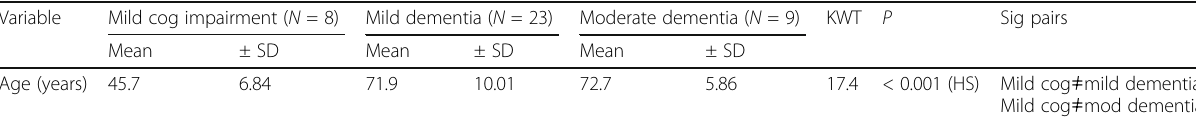
Table 6 Distribution of the degree of dementia according to age Variable